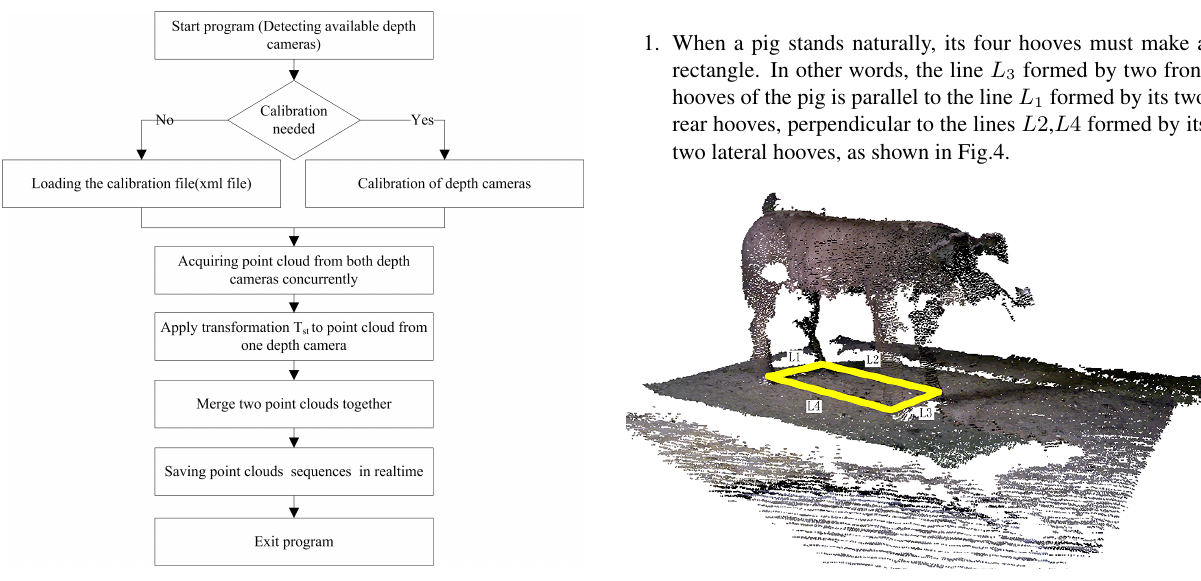
Figure 3. Whole pipeline for scanning live pig Figure 4. One example of qualified scanning frame with correct